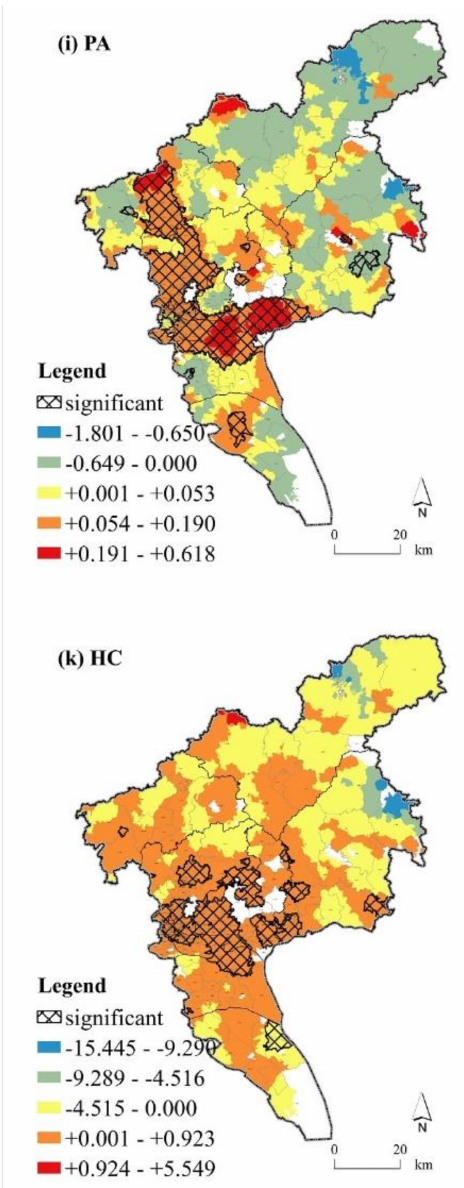
Figure 6. Spatial distribution and regression coefficients for the 11 factors based on the GWR model for Hive Boxes in Guangzhou: ( a ) Total population, ( b ) urbanization rate, ( c ) POI of living facilities, ( d ) POI of working facilities, ( e ) POI of public facilities, ( f ) road density, ( g ) building density, ( h ) building floor, ( i ) population aging, ( j ) number of working people, and ( k ) housing